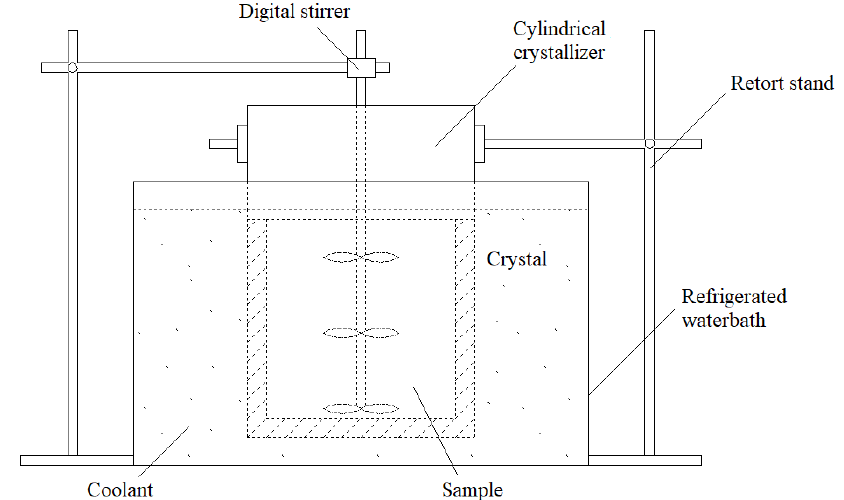
Figure 1. Experimental setup for the fractional freezing process.